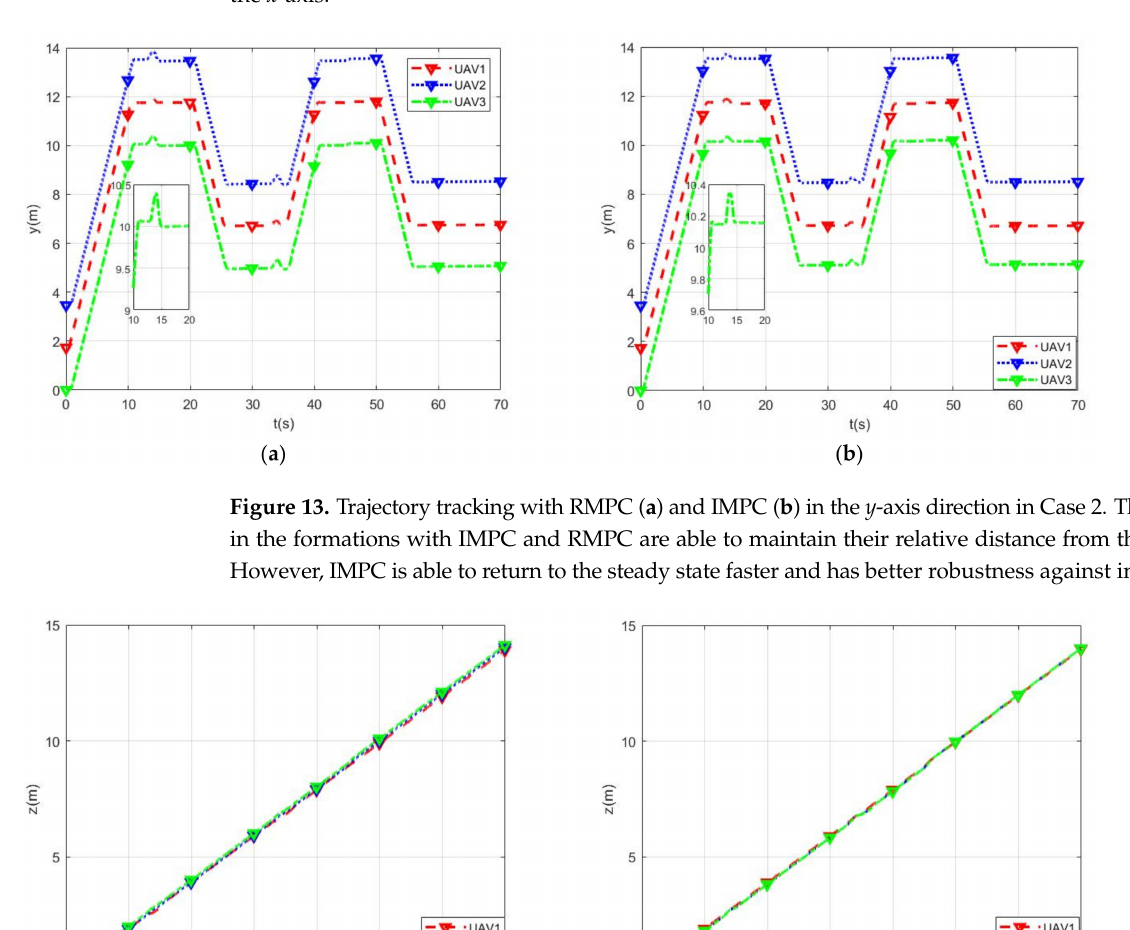
Figure 12. Trajectory tracking with RMPC ( a ) and IMPC ( b ) in the x -axis direction in Case 2. The UAVs in the formations with IMPC and RMPC are able to maintain their relative distance from the x -axis.